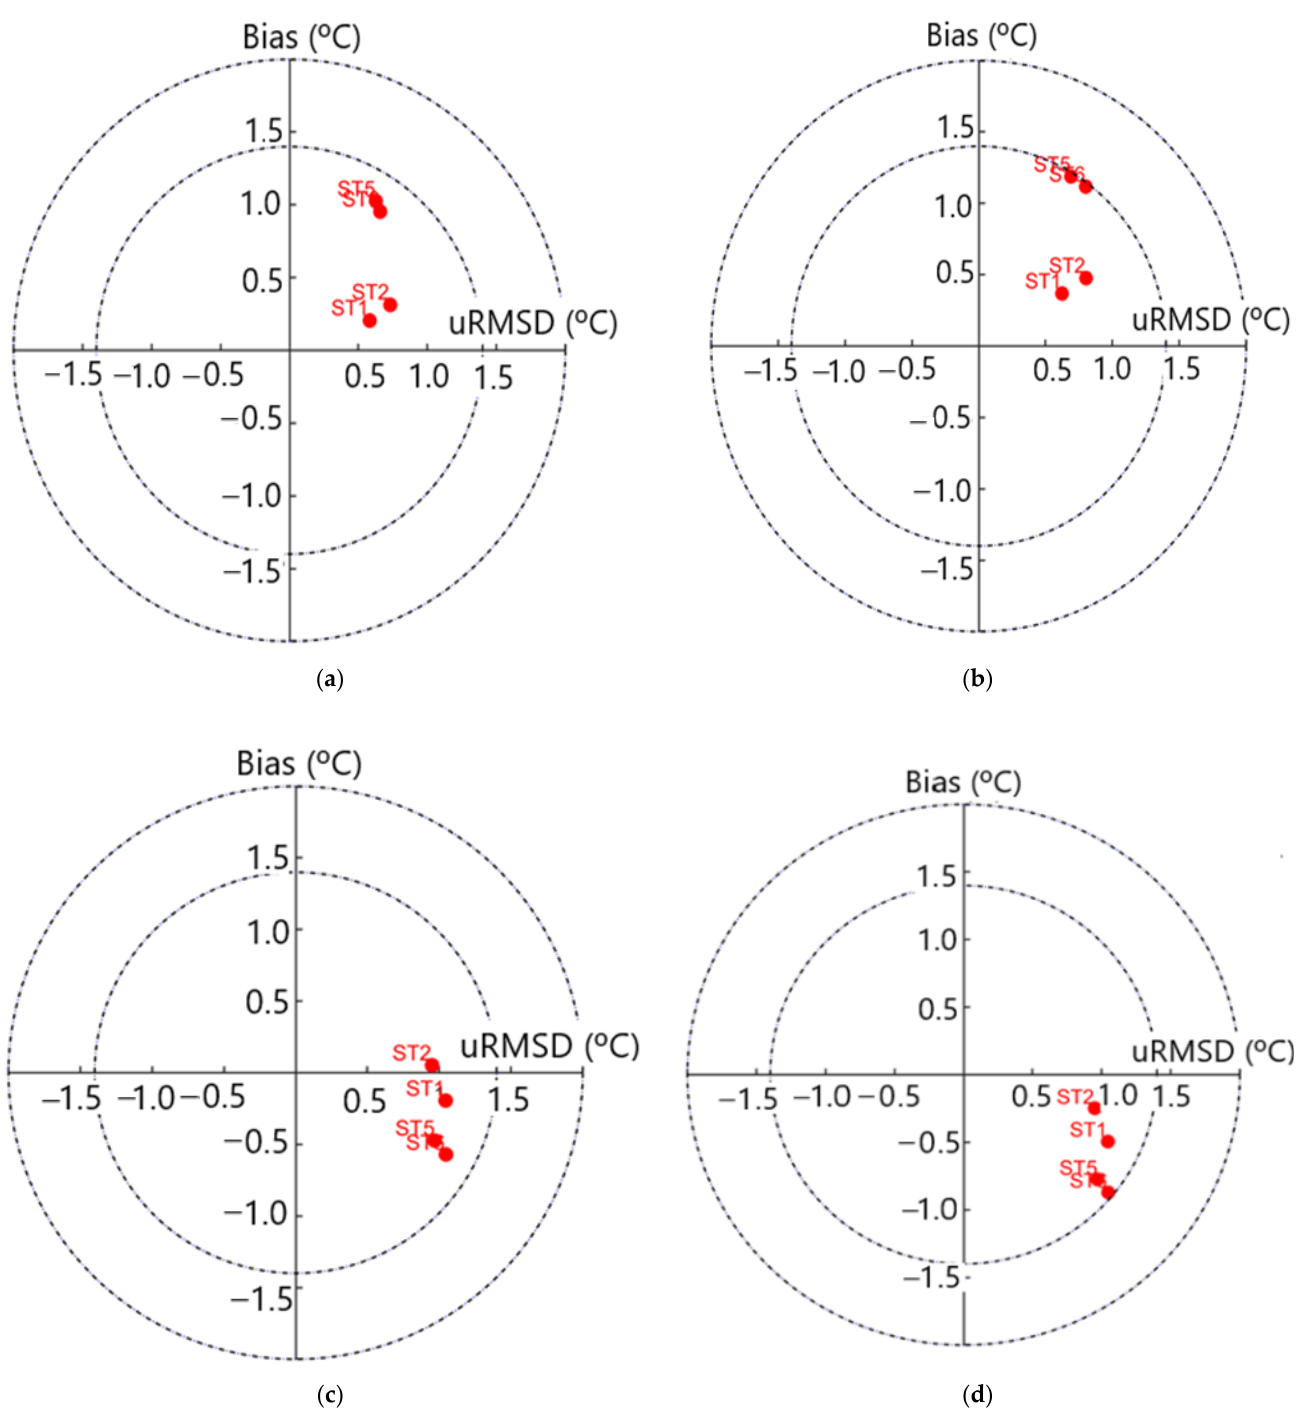
Figure 8. Target diagrams for temperature for St1 ( a ), St2 ( b ), St5 ( c ), and St6 ( d ).